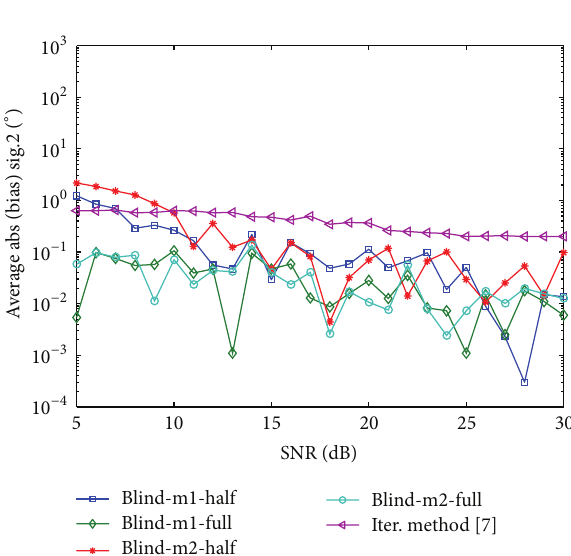
Figure 4: Average DOA absolute bias versus SNR for signal 2.